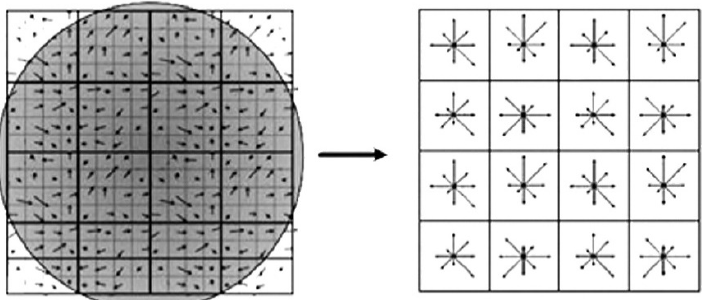
Figure 13. Background feature descriptor. Each small square represents a pixel, the arrow on the small square represents the gradient information of each point, the direction of the arrow is the direction of the gradient, and the length of the arrow represents the magnitude of the gradient.